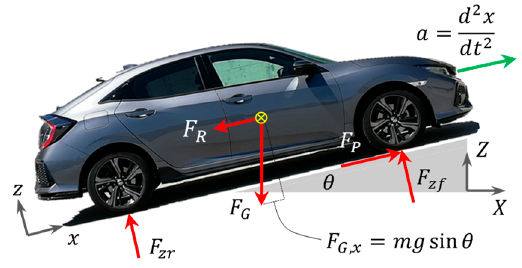
Figure 3. Free-body diagram of a road vehicle.